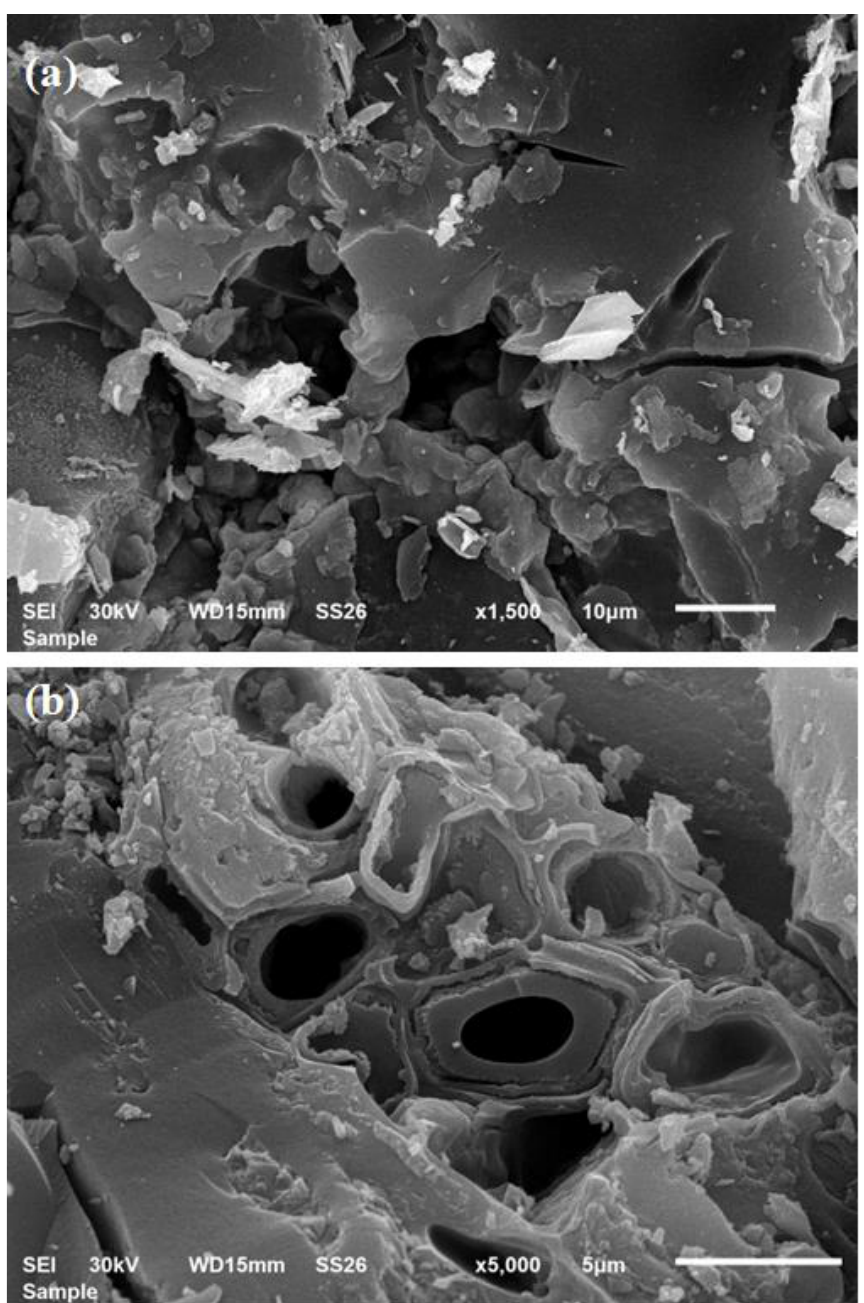
Figure 1. SEM images of the prepared activate carbon: ( a ) magnification 1500 ( b ) magnification 5000.